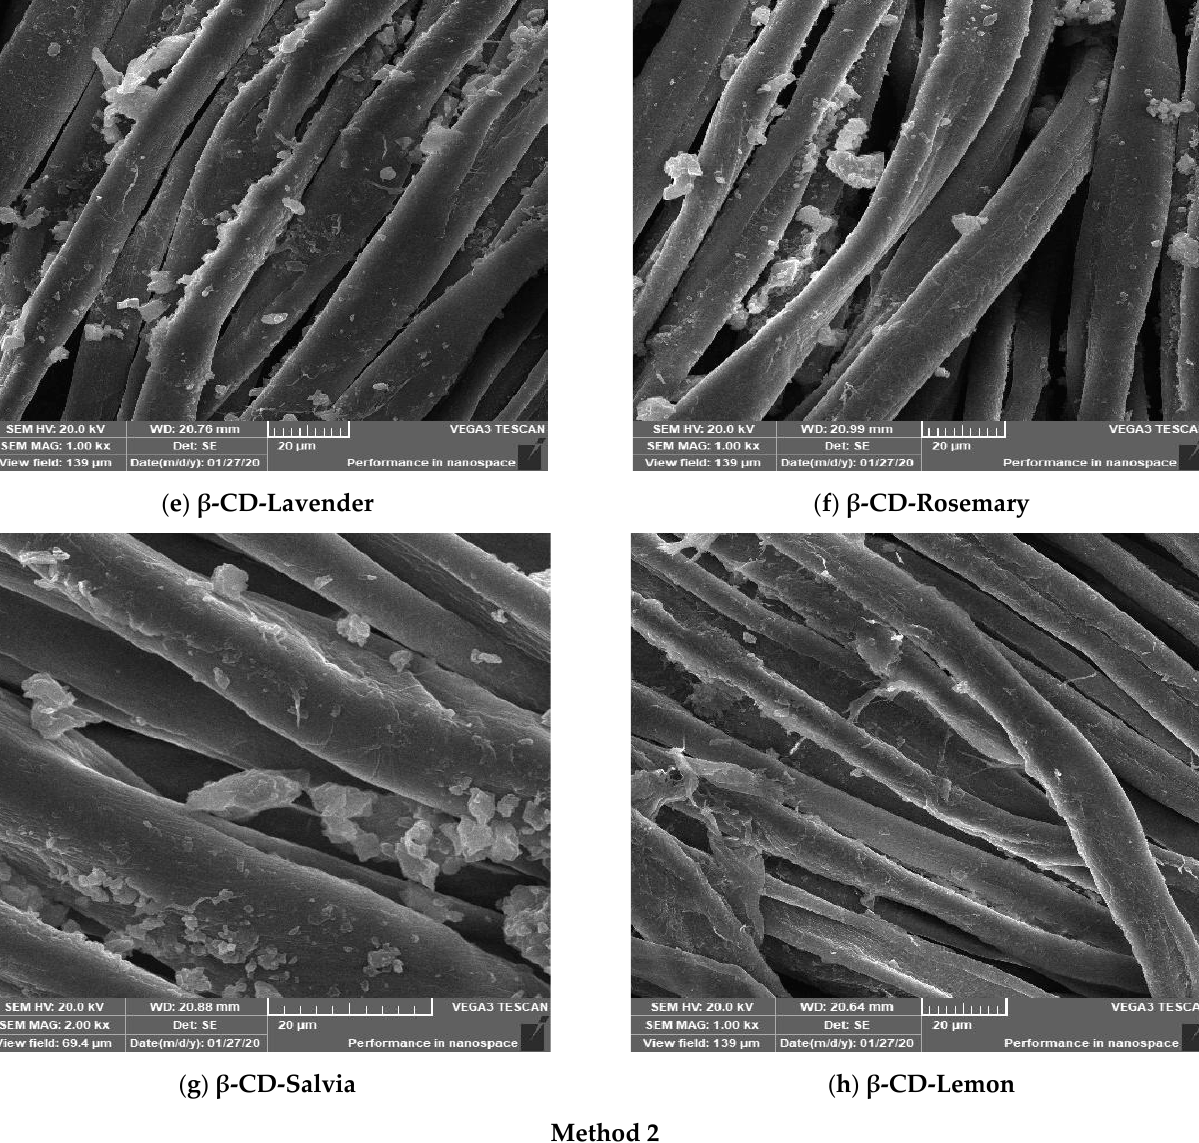
Figure 2. SEM images of blank cotton cellulose and β -CD-EO S treated samples.